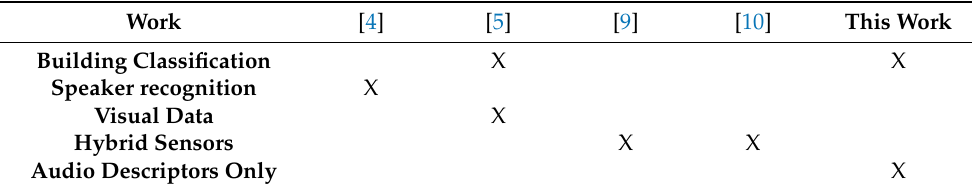
Table 13. Comparison with other